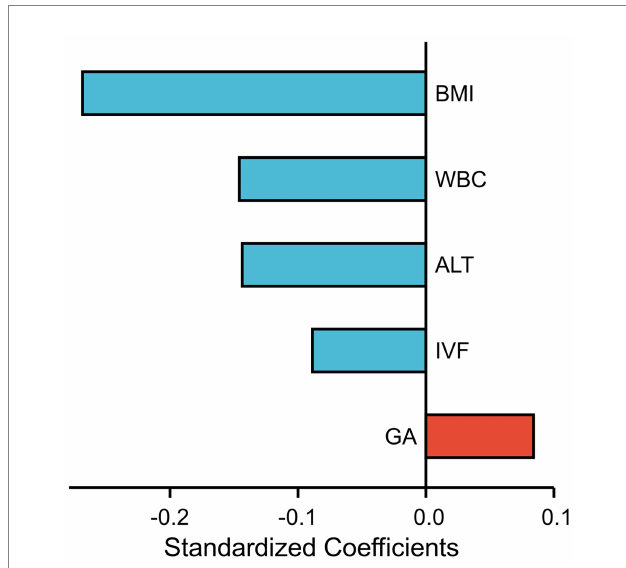
FIGURE 2 Each factor’s contribution in the multivariate linear regression analysis is measured by standardized